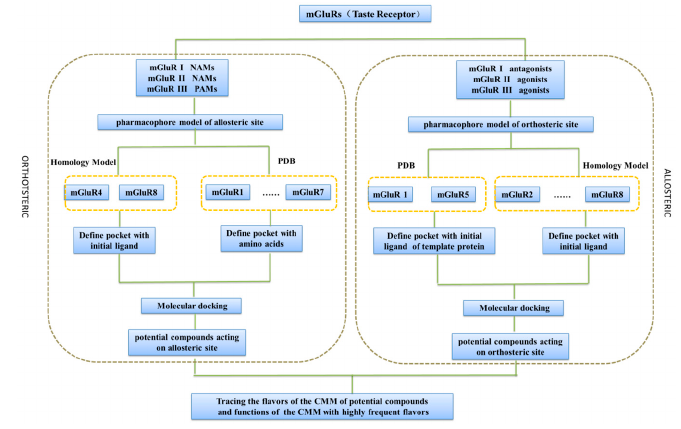
Figure 1. The strategy of analyzing the association relationship between flavor and neuroprotection of traditional Chinese medication (TCM) based on the metabotropic glutamate receptors